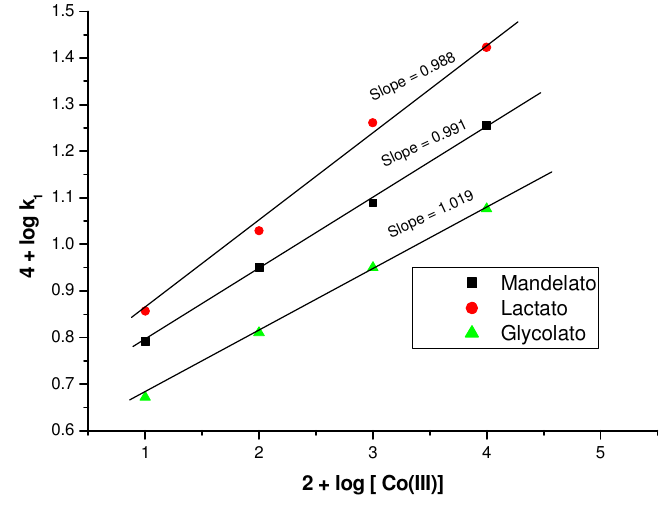
Figure 3. Dependence of rate on [ Co(III)] in